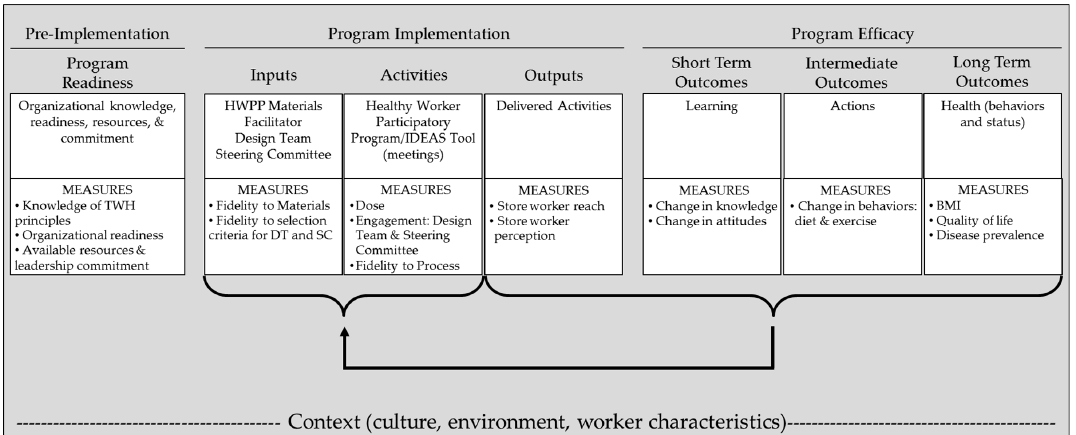
Figure 2. Logic model for evaluating the Healthy Workplace Participatory Program (HWPP).